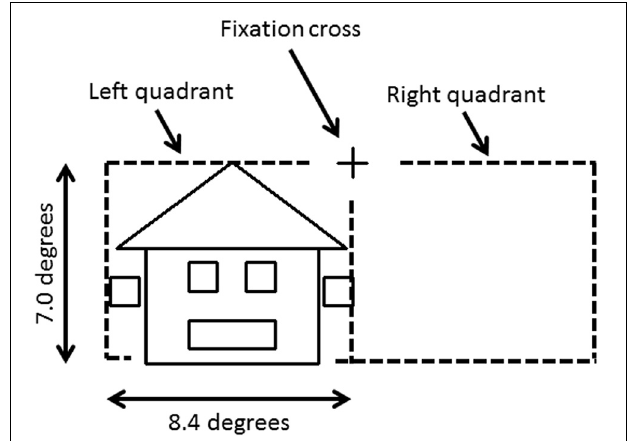
FIGURE 1 | Stimulus image and projected hemifield. The fixation cross is located in the center of the screen. Each stimulus was projected in the lower left or right quadrant, and covered up to 7.0 ◦ below the fixation cross and up to 8.4 ◦ on either